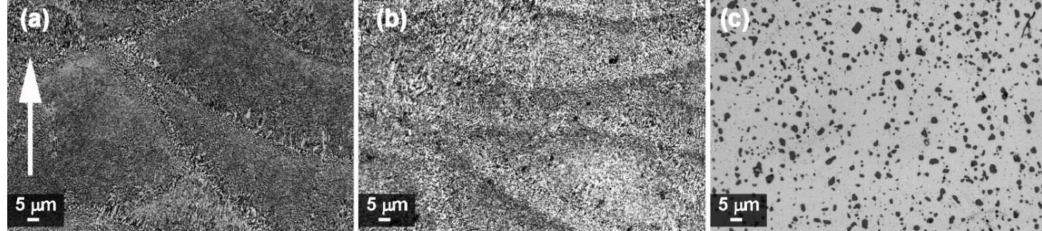
Figure 4. Optical images of A357 samples: ( a ) as-built; ( b ) after stress-relieving; ( c ) after T6 B,170,3 heat treatment. The white arrow indicates building